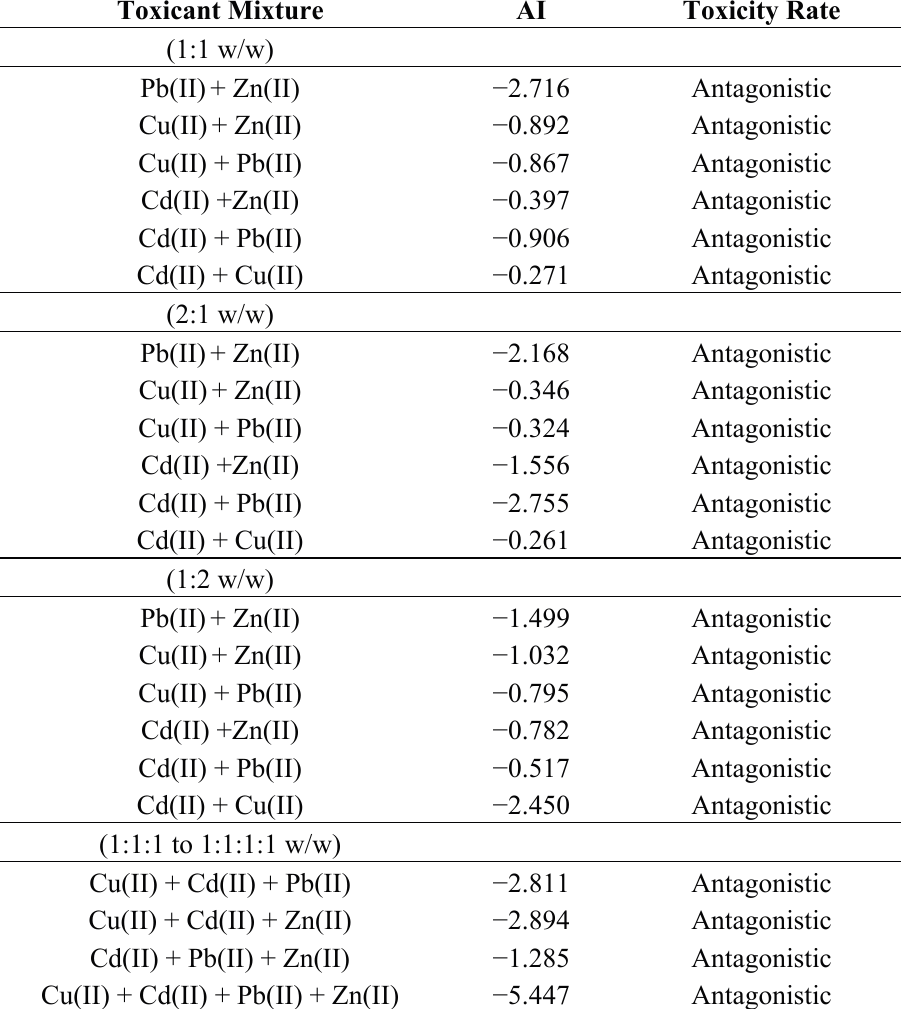
Table 5. The AI value and toxicity level of the toxicity biosensor for toxicant mixture